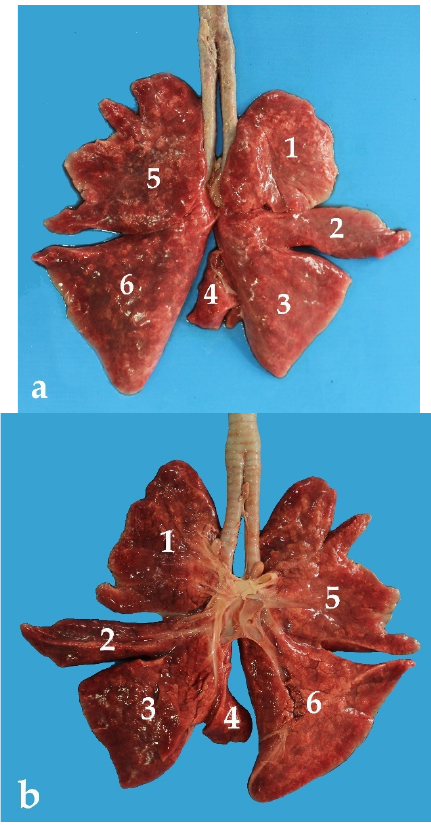
Figure 12. Lungs of Arctocephalus australis : ( a ) dorsal view; ( b ) ventral view; (1) right cranial lobe; (2) right middle lobe; (3) right caudal lobe; (4) right accessory lobe; (5) left cranial lobe; (6) left caudal lobe.